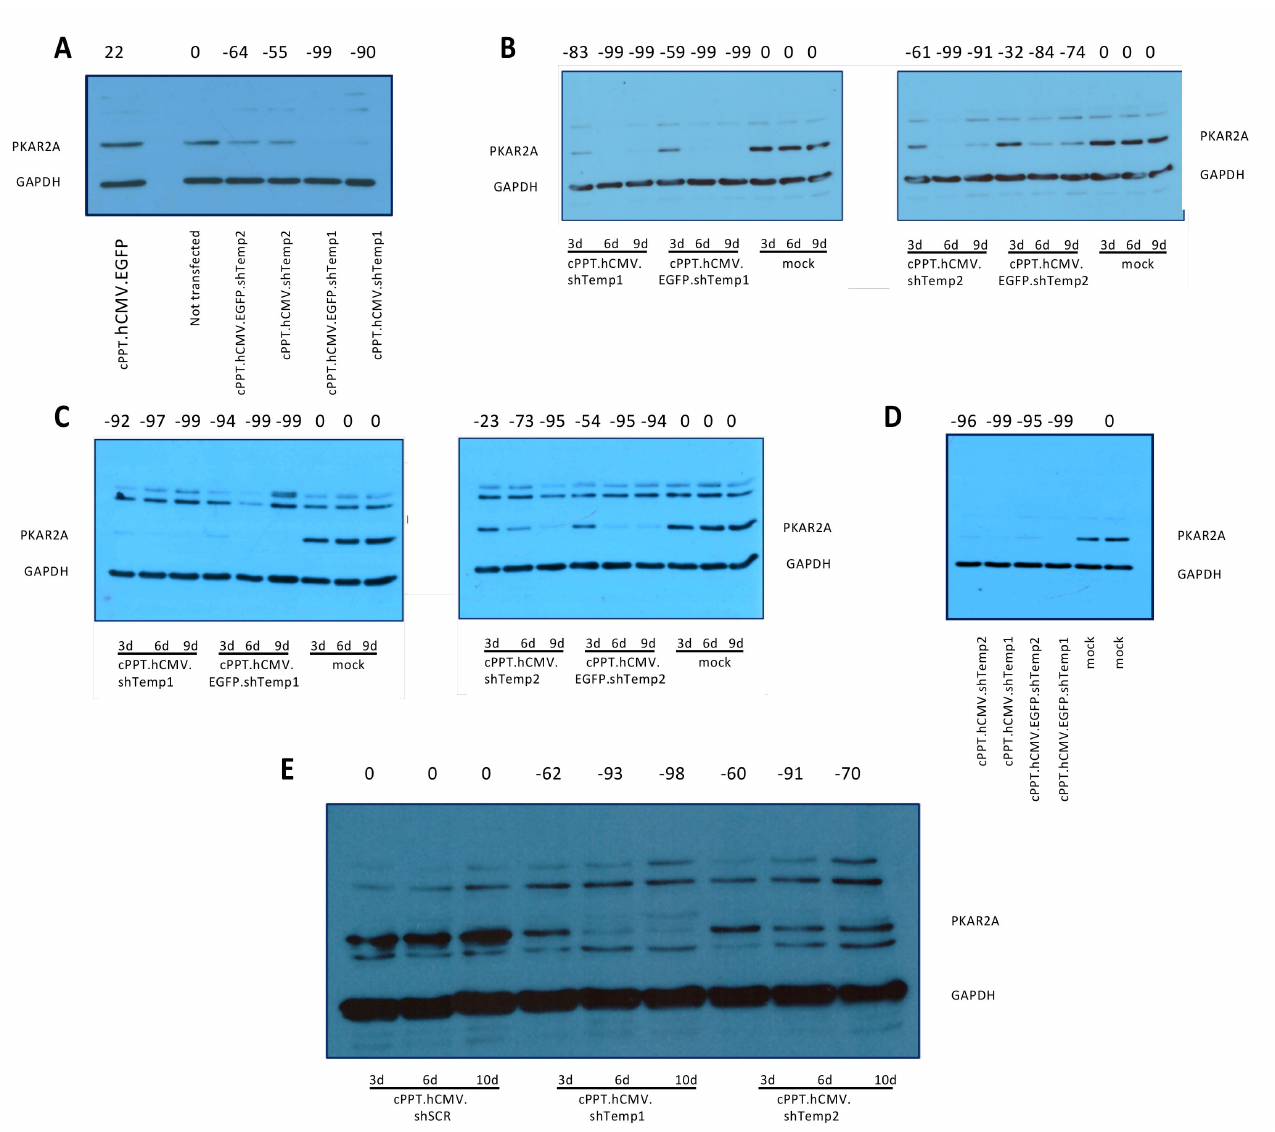
Figure 2. Developed lentiviral vectors mediate specific and long-lasting silencing of PKA. Western blot analysis of ( A ) 293T cells transfected with the developed lentiviral vectors analyzed 72 h posttransfection. ( B – E ) Western blot analysis of 293T ( B ) and U87 ( C , D ) cells, transduced with equivalent RT units of the recombinant lentiviral particles, as indicated, analyzed 3, 6, and 9 ( B , C ), 33 ( D ), or 3, 6, and 10 ( E ) days post-transduction. Bands were quantified and the percentage of reduction, calculated relative to non-transfected ( A ), mock ( B – D ) or scramble (shSCR, E ), is indicated above each line. ( D ) the mean of two mock lanes was used. Primary antibodies: PKA R2A and GAPDH; secondary antibody: anti-rabbit HRP conjugated. Recombinant lentiviral particles lead to efficient silencing of PKA R2A in GBM